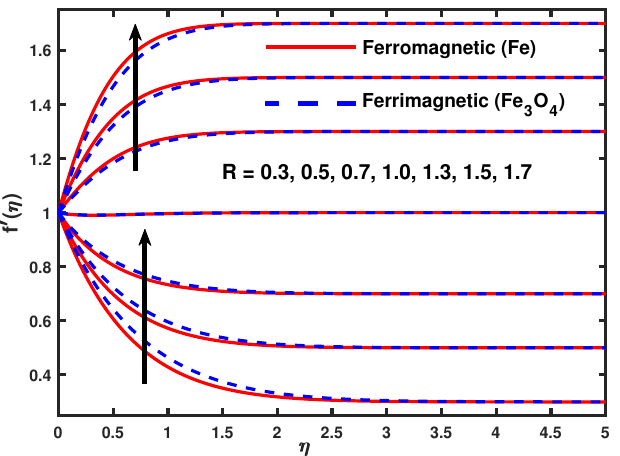
Figure 13. Impact of magnetic nano-particles and R (the ratio of Q and S ) on the velocity profile f (cid:48) ( η ) .